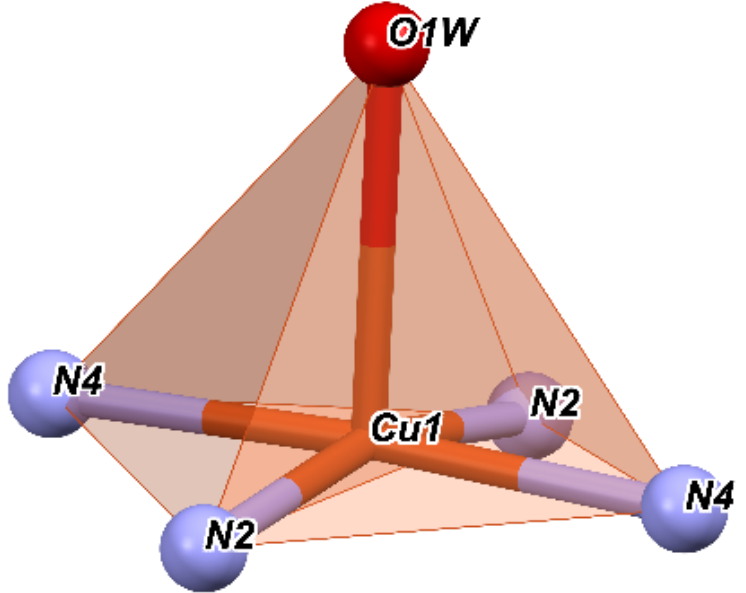
Figure 7. Coordination polyhedron of complex C2 .